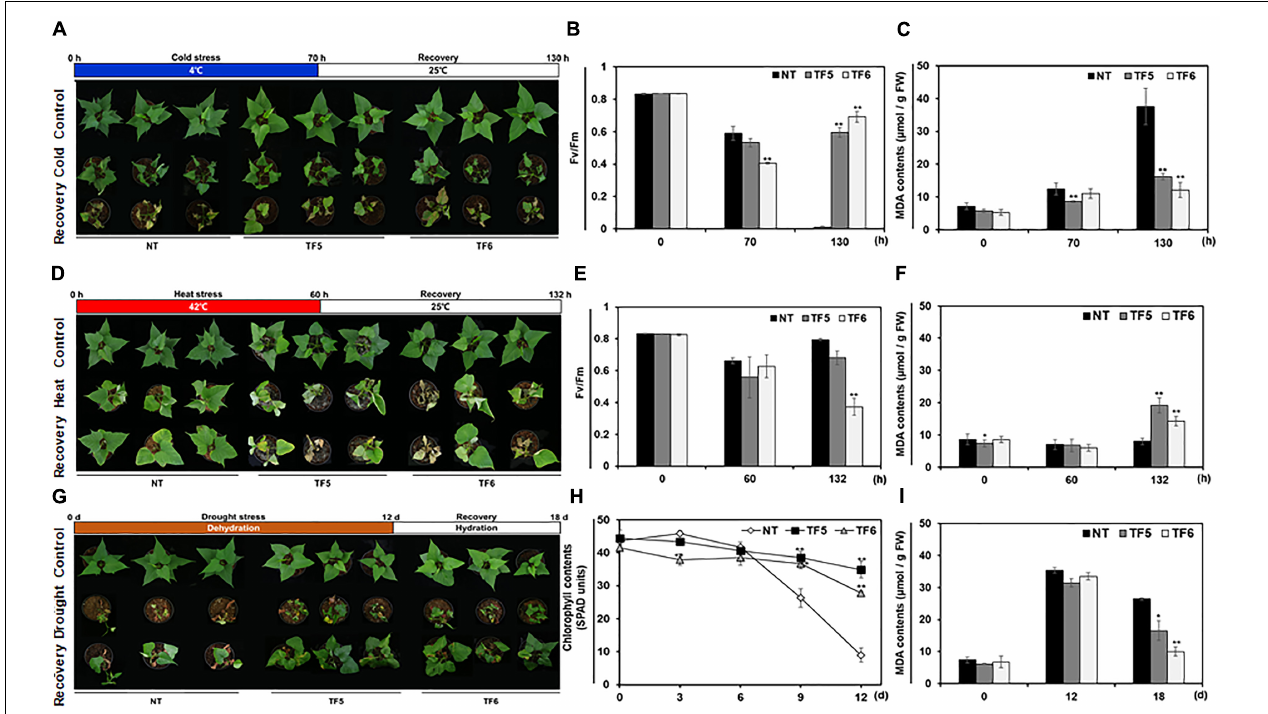
FIGURE 4 | Evaluation of the abiotic stress tolerance of TF plants. (A) Phenotypic changes in TF plants exposed to cold (4 ◦ C) stress for 70 h, followed by recovery at 25 ◦ C for 60 h. (B,C) Fv/Fm values (B) and malondialdehyde (MDA) contents (C) of sweetpotato leaves after cold stress treatment and recovery. (D) Phenotypic analysis of TF plants treated with heat stress (42 ◦ C) for 60 h, followed by recovery for 72 h. (E,F) Fv/Fm values (E) and MDA contents (F) of sweetpotato leaves after heat stress treatment and recovery. (G) Phenotypes of TF plants treated with drought stress for 12 day, followed by rehydration for 6 day. (H,I) Chlorophyll contents (SPAD units) (H) and MDA contents (I) of sweetpotato leaves during drought stress treatment and recovery. Asterisks indicate significant differences between TF and NT plants (* p < 0.05, ** p <